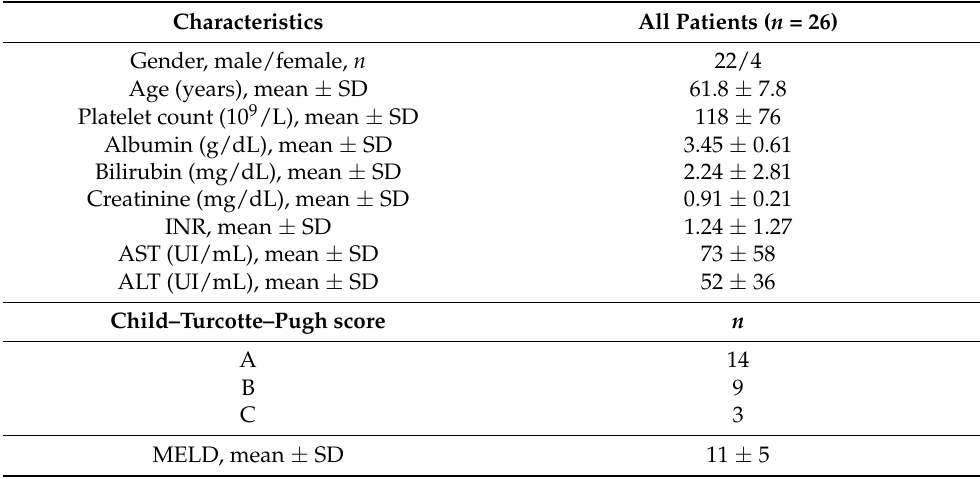
Table 1. Patients’ demographic and histopathological